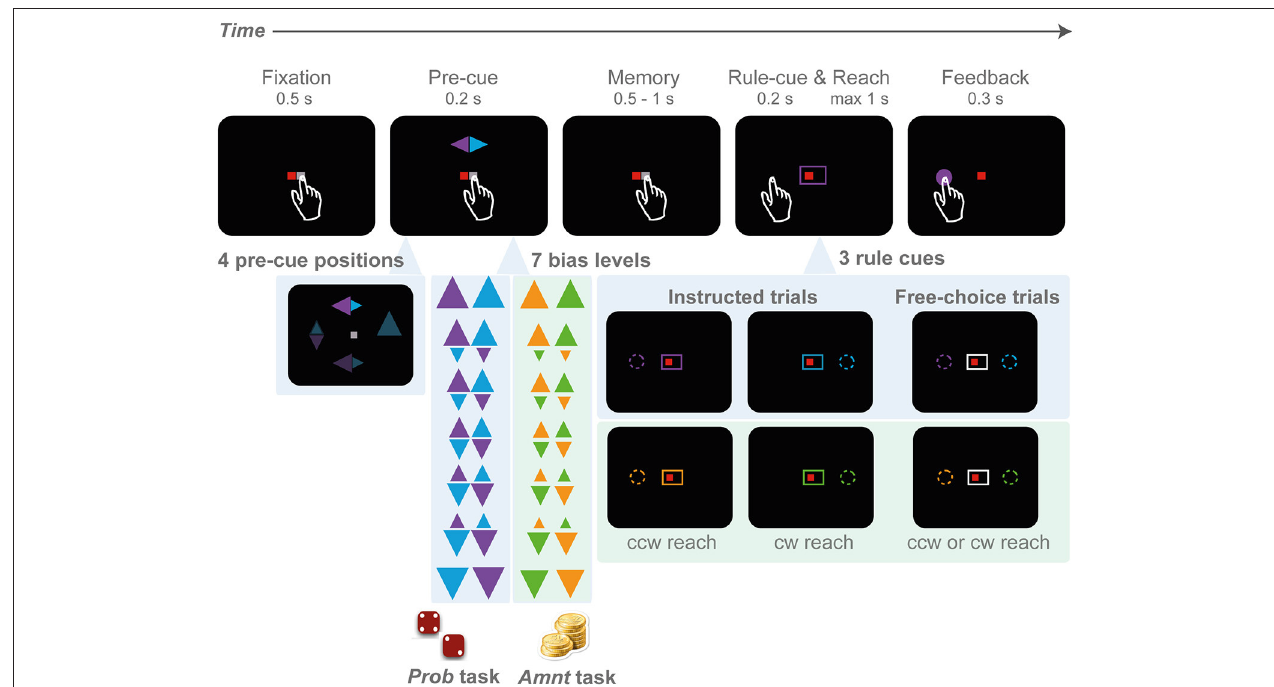
FIGURE 1 | Rule-selection tasks with probabilistic (PROB) and amount (AMNT) bias manipulations. A trial starts with eye-hand fixation. Next, a pre-cue appears at one of the four cardinal locations (top, down, left, right), indicating two potential goals and the probability of each goal in the PROB task (big triangle - high probability), or the reward amount associated with each goal in the AMNT task (big triangle - more reward). In the PROB task, the reward amount is kept constant in all conditions, whereas in the AMNT task the probability is kept equal in all conditions. After a memory period, the rule-cue appears and either indicates one valid target or leaves the options open so that subjects can freely choose. Both options in choice trials always provide equal